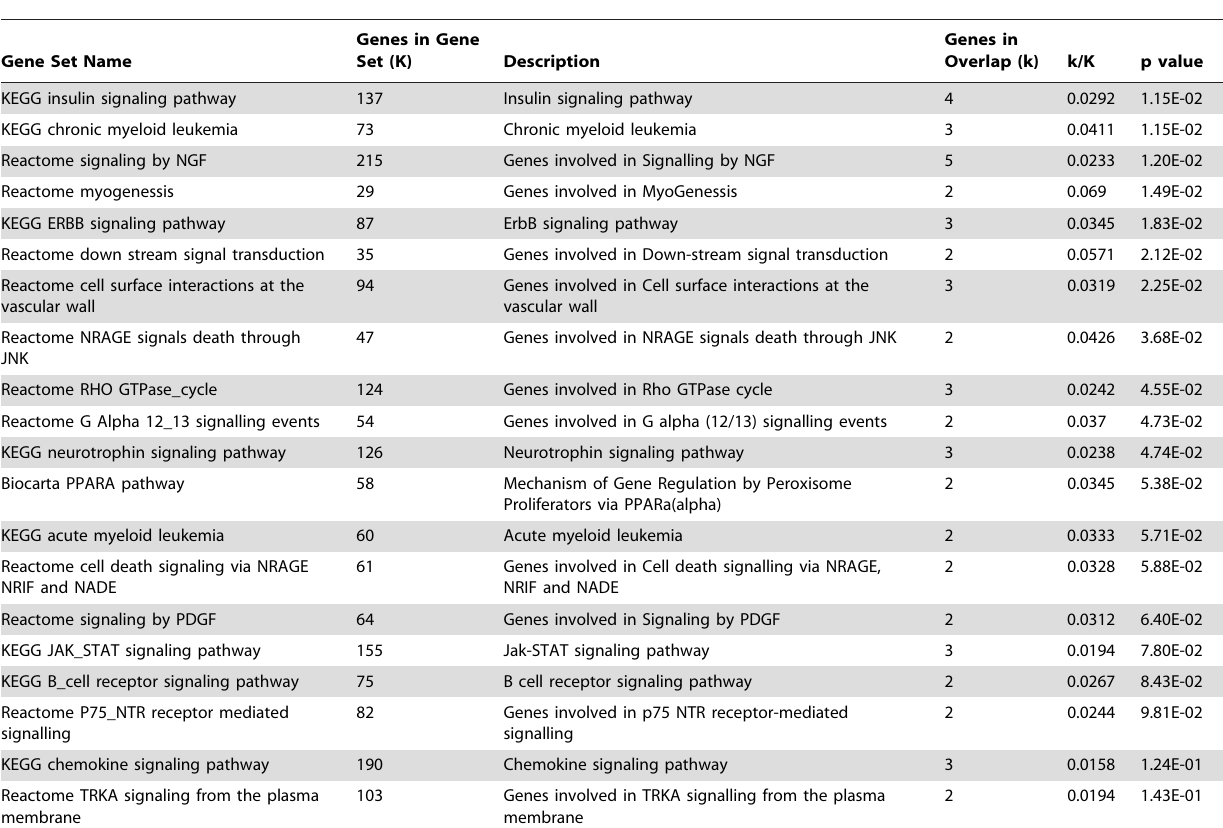
Table 3. Mostly potential pathways of disorder model